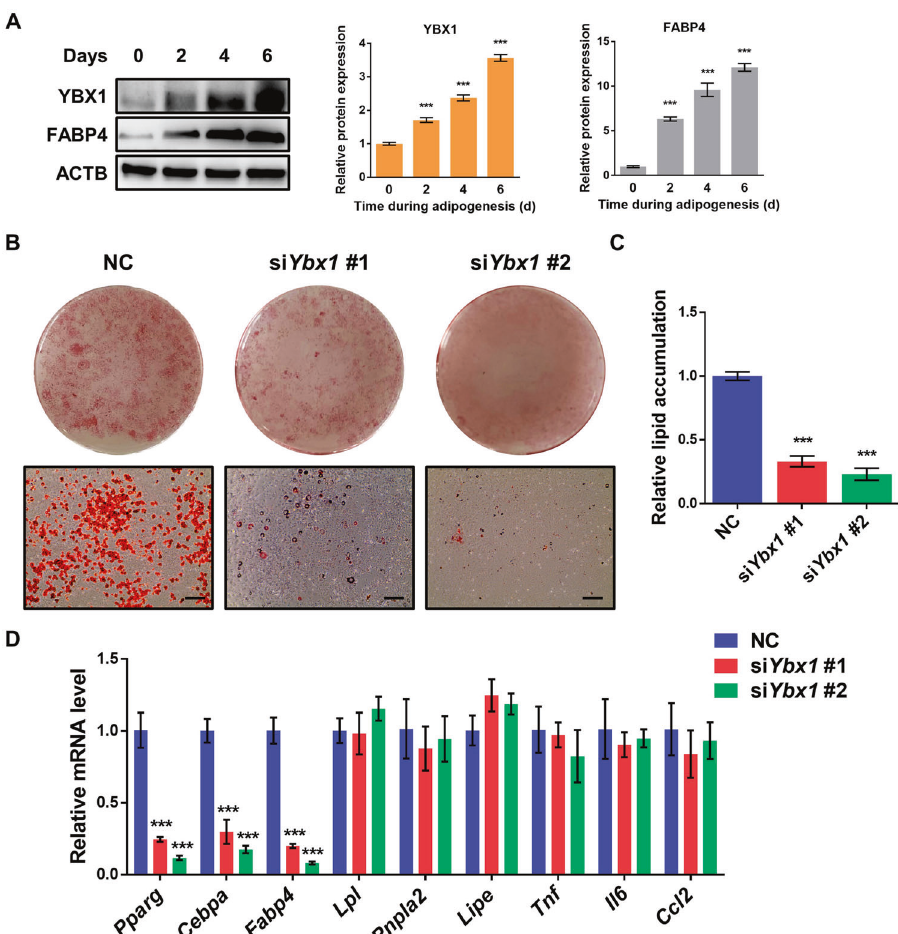
Fig. 1 YBX1 de fi ciency attenuates adipogenesis and lipid accumulation of mouse 3T3-L1 preadipocytes. A Western blot analysis of YBX1 and FABP4 expression during adipogenesis of 3T3-L1 preadipocytes. B Oil Red O staining of negative control (NC) and YBX1 knockdown cells on day 6 of adipogenesis. Scale bar: 100 μ m. C Relative lipid accumulation was quanti fi ed with a microplate spectrophotometer at 500 nm. D Real-time quantitative PCR (qPCR) analysis of Pparg , Fabp4 , Cebpa, Lpl, Pnpla2, Lipe, Tnf, Il6 and Ccl2 expression in NC and YBX1 knockdown cells on day 6 of adipogenesis. The data were presented as the mean ± SD of triplicate tests. *** P < 0.001 compared to control